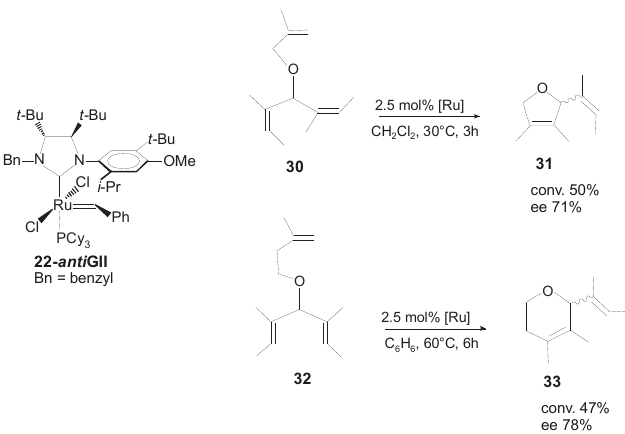
Scheme 8. Asymmetric ring closing metathesis of 30 and 32 catalyzed by 22- anti GII .